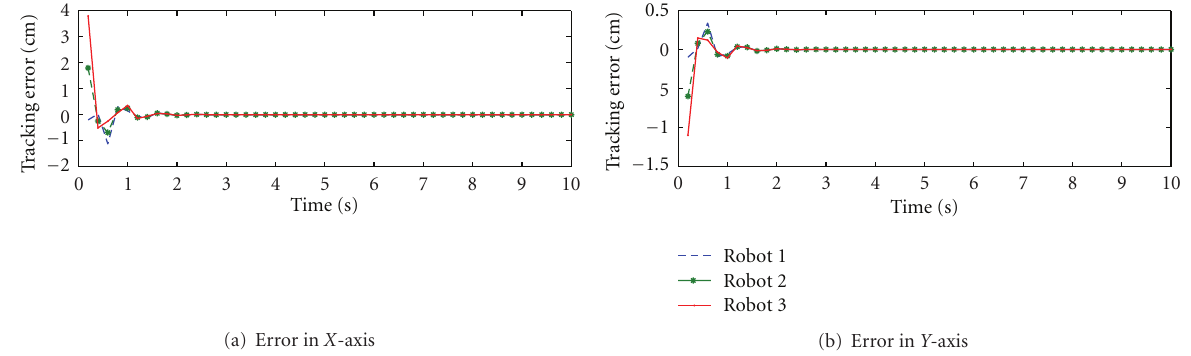
Figure 7: Tracking errors of the group with time delay ( τ = 1 second): (a) X -axis; (b) Y -axis.